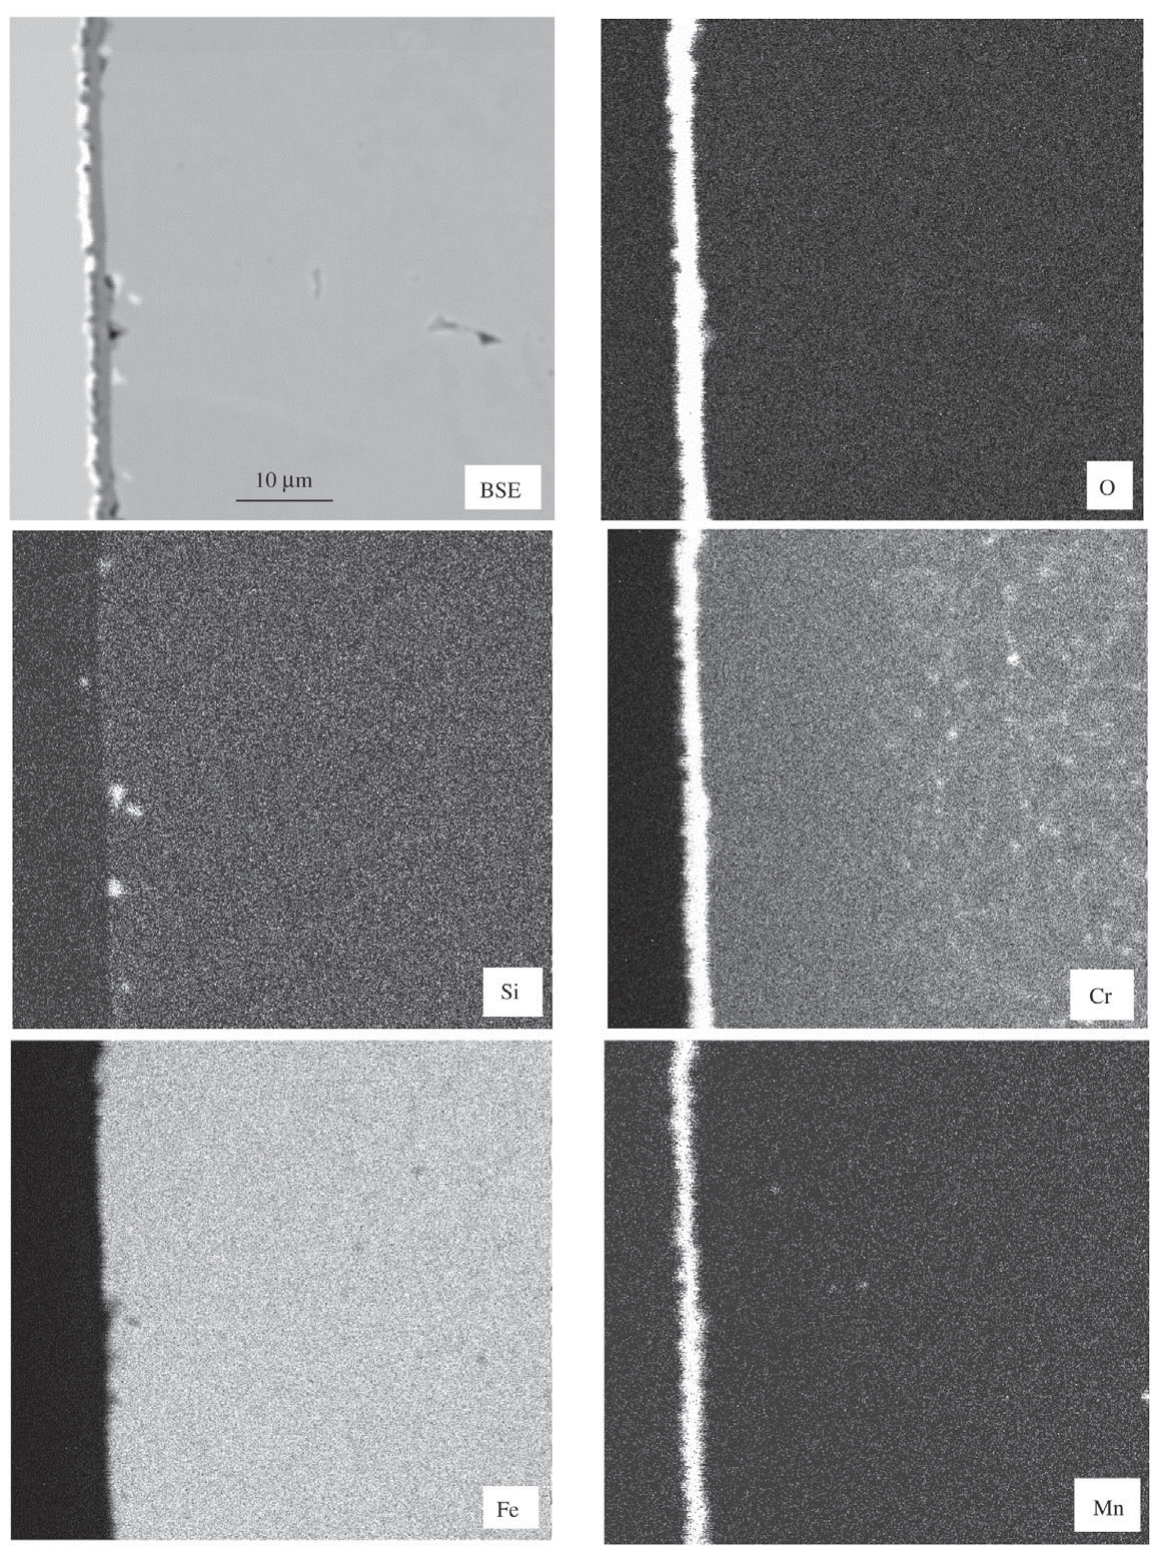
Figure 10. Elemental distribution maps for P91 at 650 °C in dry synthetic air after 10000